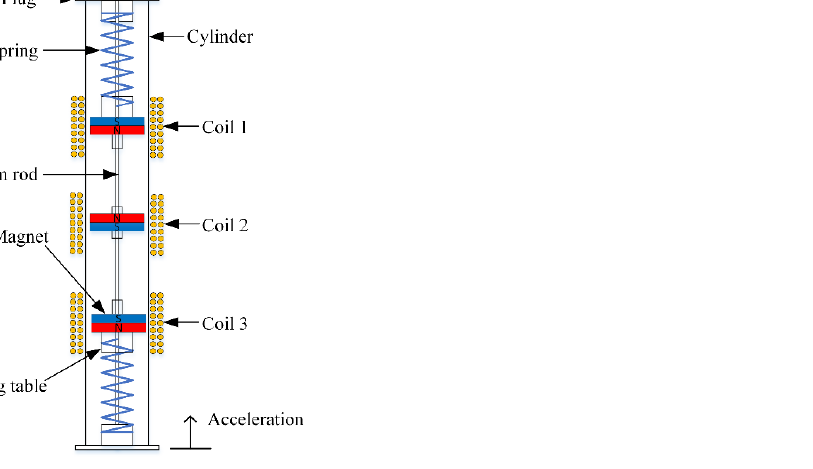
Figure 1. Schematic diagram of the magnetically coupled electromagnetic energy harvester.